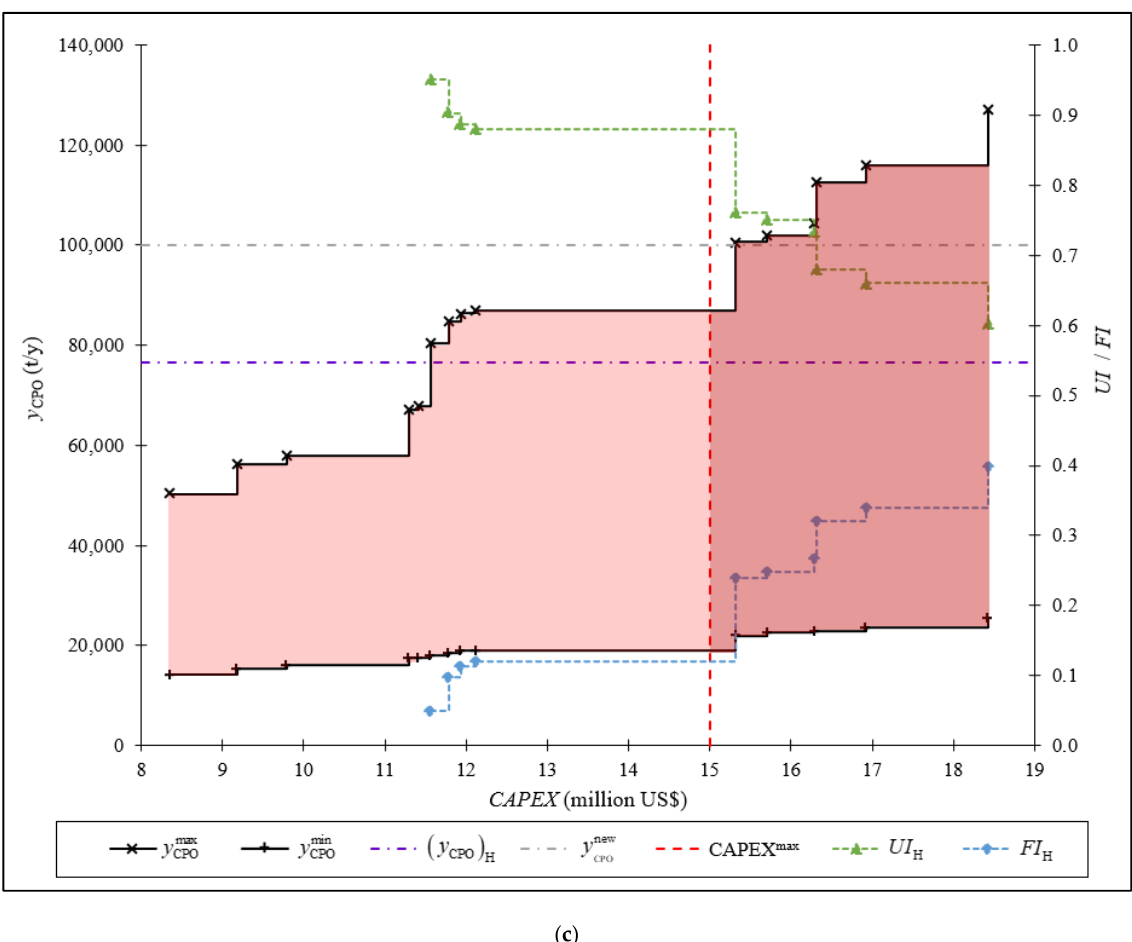
Figure 6. ( a ) Graphical representations for FORA performed during low crop season. ( b ) Graphical representations for FORA performed during medium crop season. ( c ) Graphical representations for FORA performed during high crop season with y new